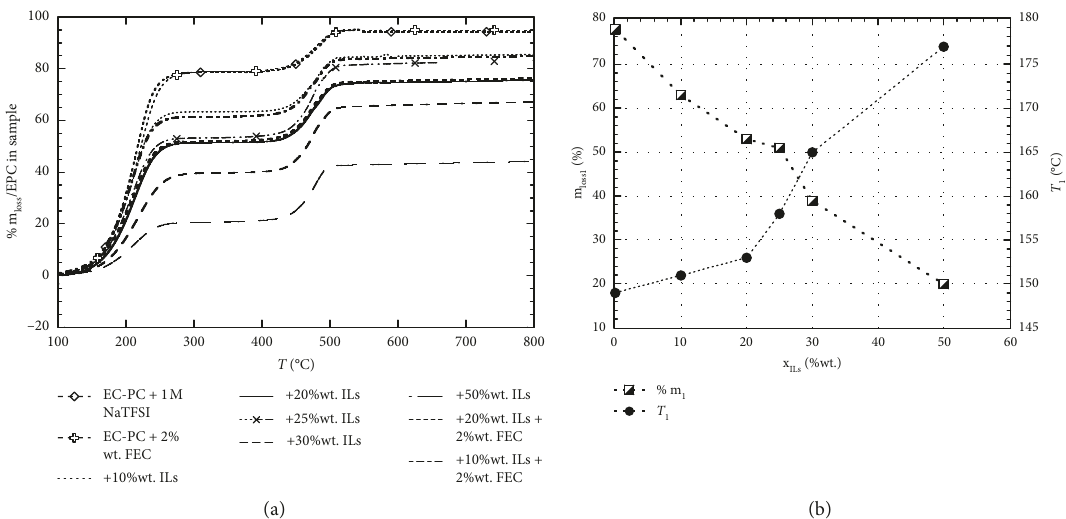
Figure 1: TGA diagrams of EC-PC (1:1)+ x wt.% EMI-TFSI (a) and the evolution of 1 st degradation temperature and 1 st weight loss of the mixtures